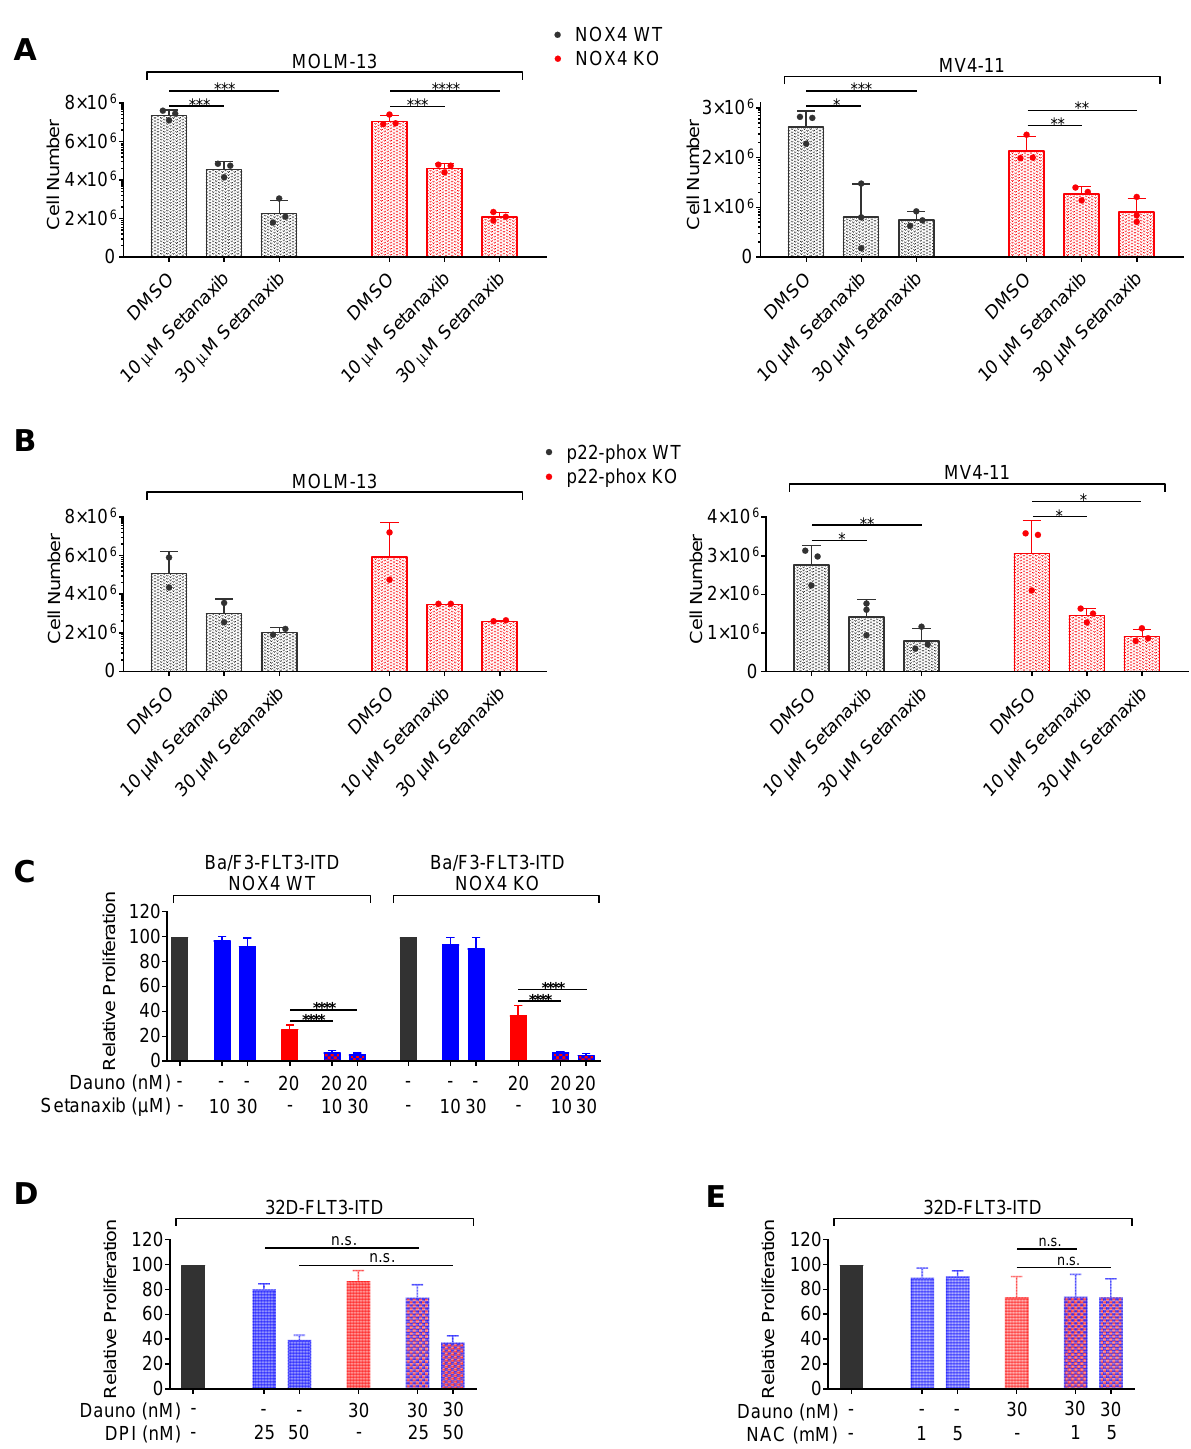
daunorubicin, when using FLT3-ITD-transduced Ba/F3 cells (Figure 4C). Taken together, neither antiproliferative activity of Setanaxib nor synergy with daunorubicin in AML cell lines appears to be causally related to the inhibition of NOX1/4 enzymatic activity.